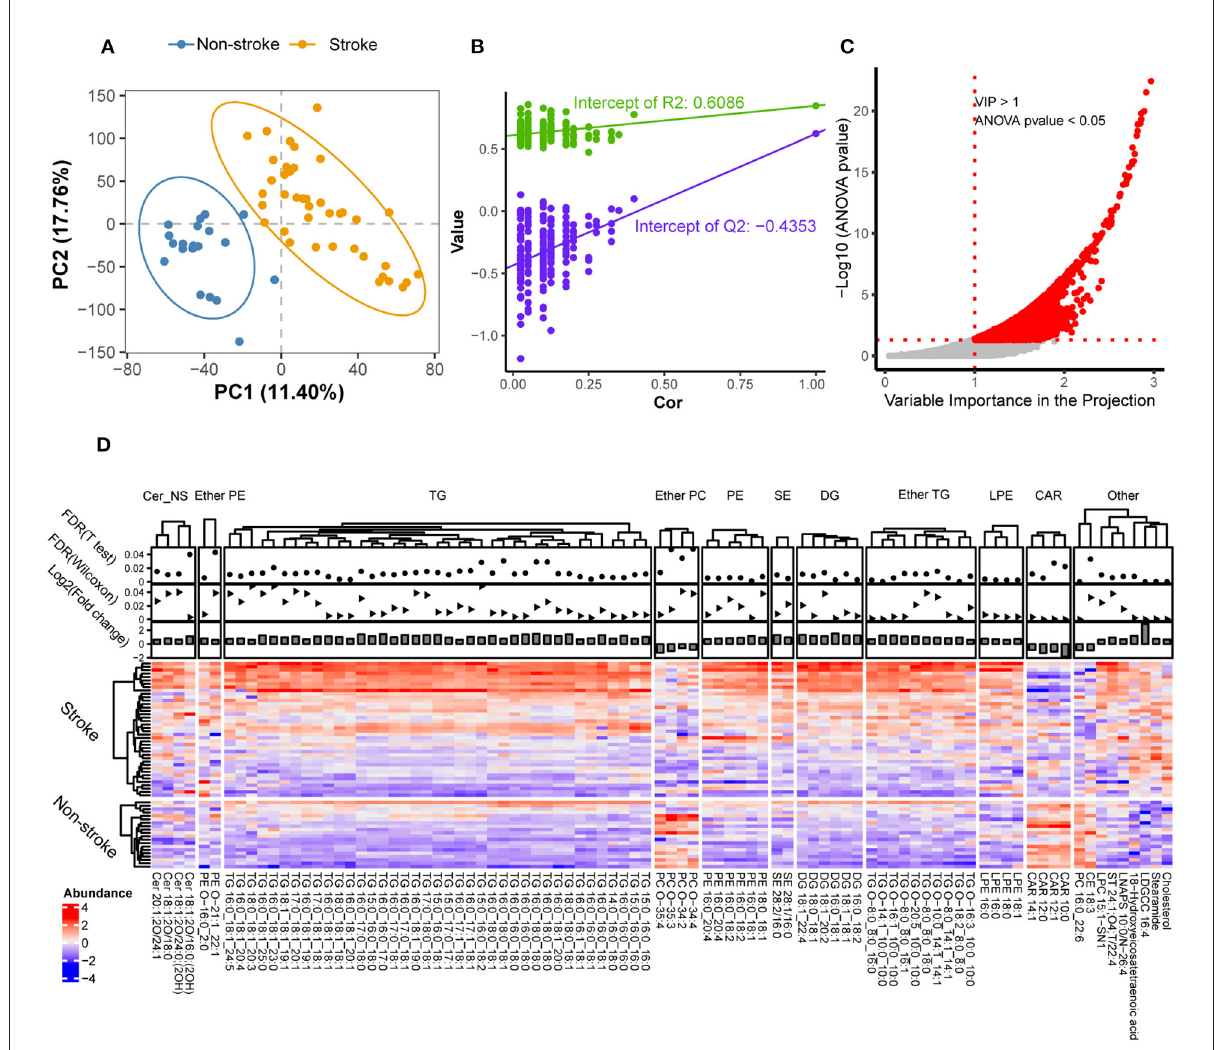
FIGURE3 Significant differences in lipids between stroke and non-stroke groups. (A) PLS-DA score plots of the two groups with different colors. The first two principal components of PC1 and PC2 were illustrated on the X -axis and Y -axis, respectively. (B) Cross-validation plot from 200 cycles permutation tests for performance evaluation of the PLS-DA model. The green and purple dots represents the intercept values of R2 and Q2 from the permutation test, respectively. (C) Scatter plot of VIP vs. –log10( p -values) for significantly changed lipid species. Two red dotted lines represent the cut-offs for VIP > 1 and p -value < 0.05, respectively. (D) Significantly altered lipids are illustrated by a heatmap. Red indicate high abundance and blue indicate low abundance. Z -score method was used to calculate the normalized abundances for each row. Each column represents a specific lipid feature. And they were divided into 11 lipid classes according to their headgroups. A solid circle and triangle point graphs provided the false discovery rate of differentially expressed metabolic features with T -test and Wilcoxon rank-sum test, respectively. The bar charts provided the log 2 fold change of differentially expressed metabolic features. Cer, ceramides; ether PE, ether-linked phosphatidylethanolamine; TG, triacylglycerol; ether PC, ether-linked PC; PE, phosphatidylethanolamine; SE, steryl esters; DG,